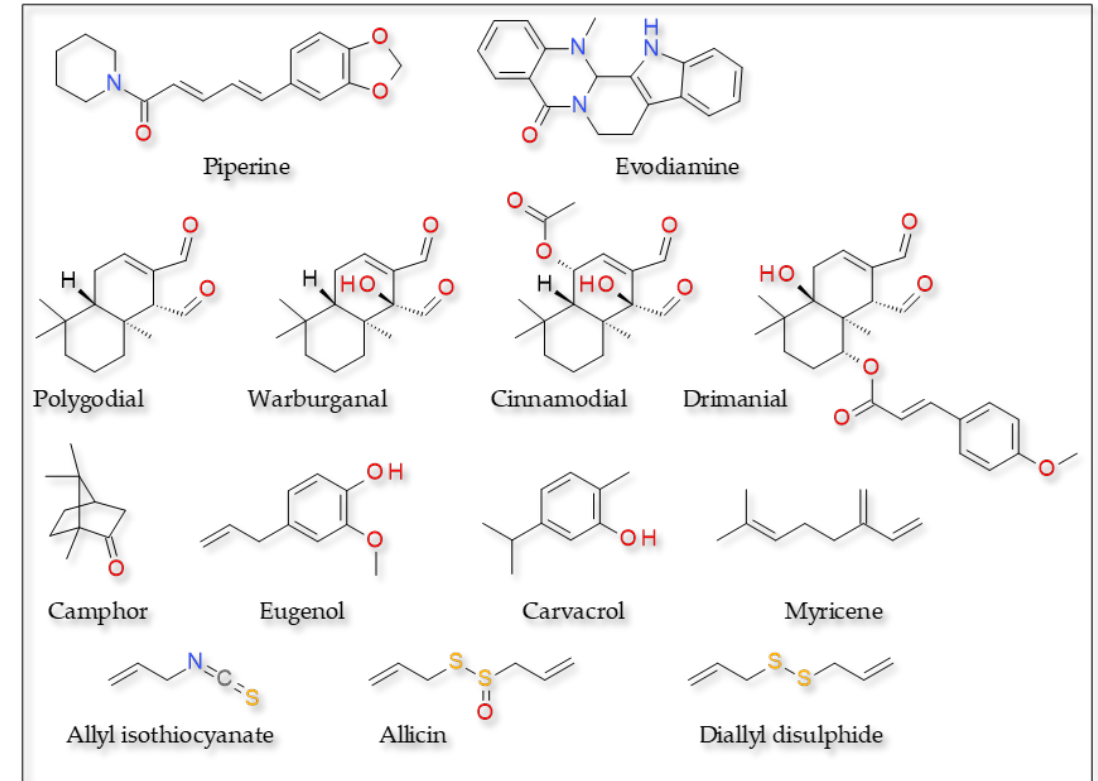
Figure 3. TRPV1 agonists — various structures.